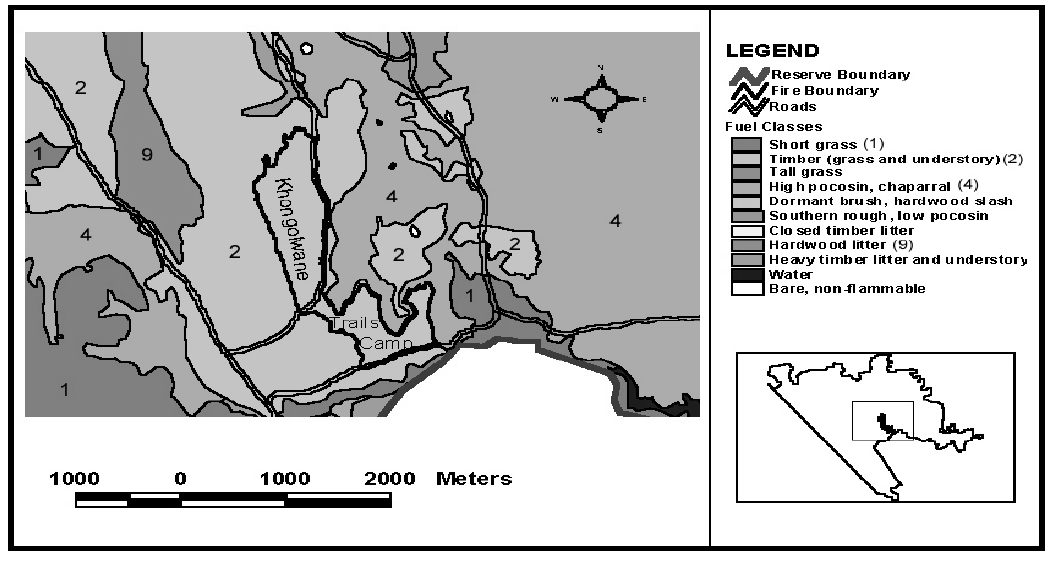
Figure 6. Map of fuel classes for the Trails Camp and Khongolwane fires